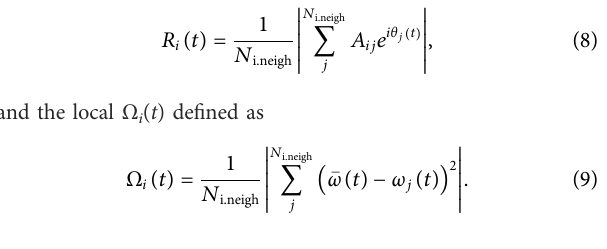
FIGURE 1 Order parameter dependence on F for the fruit- fl y connectome for the noisy (black bullet) and the noiseless (red boxes) cases at K = 1.3. The blue diamonds show the steady-state Ω values with noise. Lower inset: Variances of R and Ω for the noisy case. Upper inset: Timedependenceofthenoisy R ( t ),for F =0,0.02,0.03,0.04,0.07,0.1, 0.2, 0.3, 0.4 (bottom to top